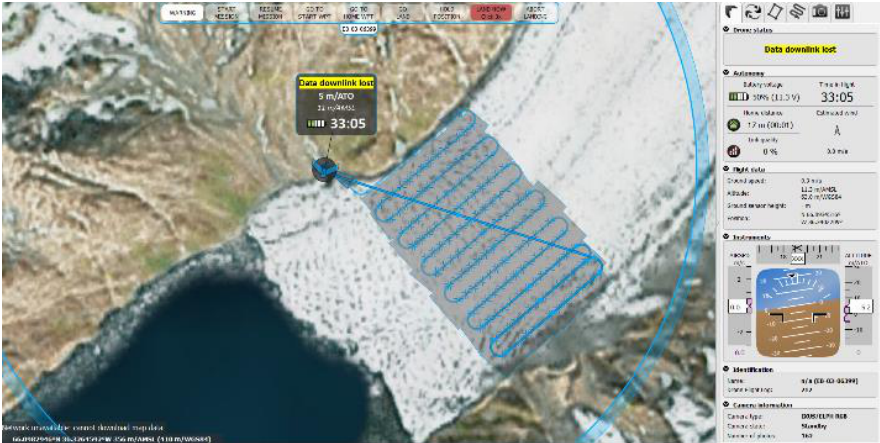
Figure 7. Flight no.1, senseFly eMotion 2 software; the map background from Google Earth was out of date (2016). The flight plan was prepared at the university before expedition, but the actual position of the glacier front was elsewhere. There was no internet on site, the flight plan had to be estimated and changed at the measurement site.